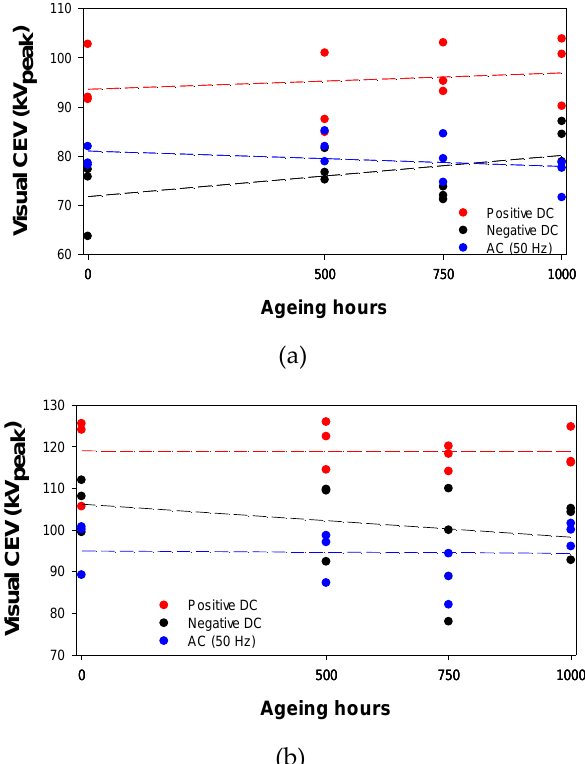
Figure 7. Corrected visual CEV values. T-type connectors. Dashed lines are the tendency lines obtained from a linear regression. ( a ) J-line connectors. ( b ) S-line connectors.